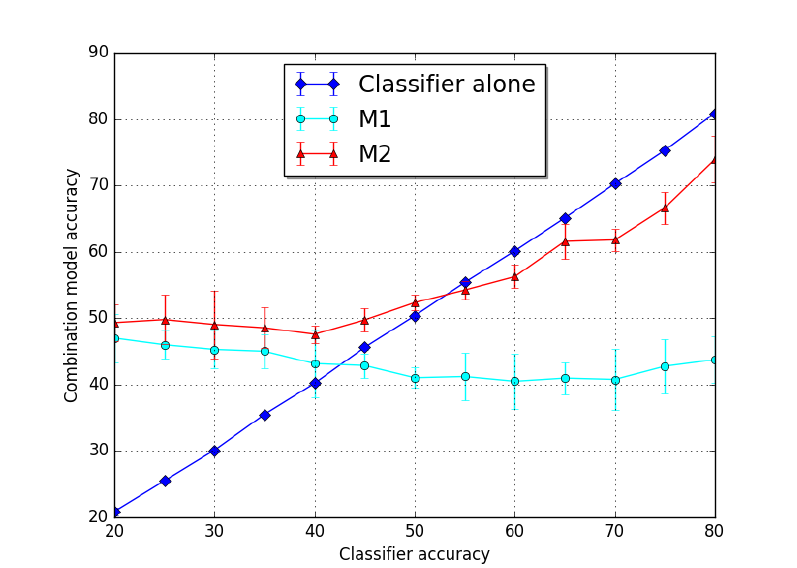
Figure 4. Performance of the two systems compared with the baseline. The error bars give the 95% confidence intervals. Results are the average of 20